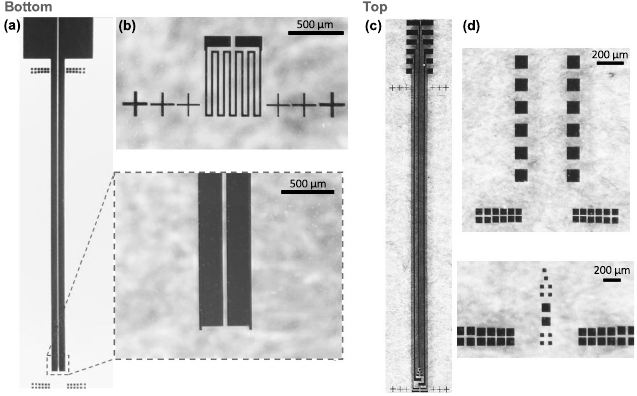
Figure 4. Lithographic masks used during fabrication process of the optrode. ( a ) RTD’s interconnection lines and pads; ( b ) RTD; ( c ) interconnection lines, recording sites, and pads for LED and recording points; ( d ) connection pads to external electronics (top) and exposure of recording sites and pads for the LED